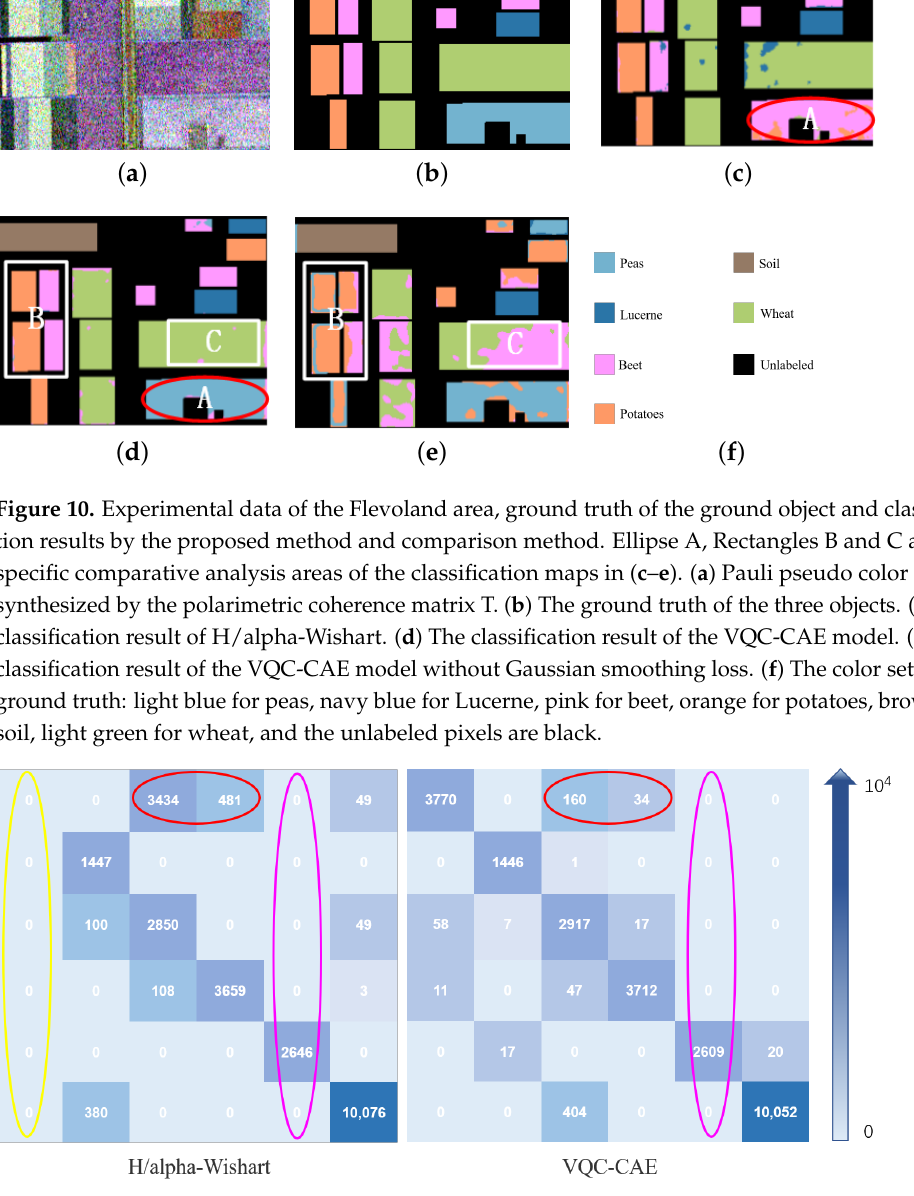
Figure 11. Confusion matrix of H/alpha-Wishart method and the VQC-CAE model. The categories from the first row to the sixth row are peas, Lucerne, beet, potatoes, soil and wheat. The blue gradient arrow on the right represents the difference of confusion matrix element values from 0 to 10 4 ; the larger the matrix element value, the darker the color. The larger the value of the non-diagonal element in the confusion matrix, the easier it is to classify pixels from other categories into this category. The larger the diagonal element, the smaller the misclassification of the